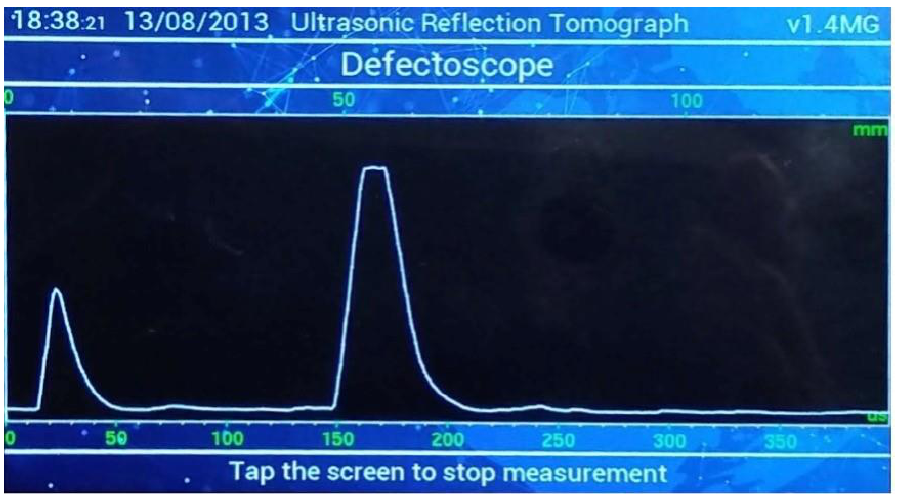
Figure 6. The defectoscopy mode uses the hardware-accelerated calculation of the signal envelope.